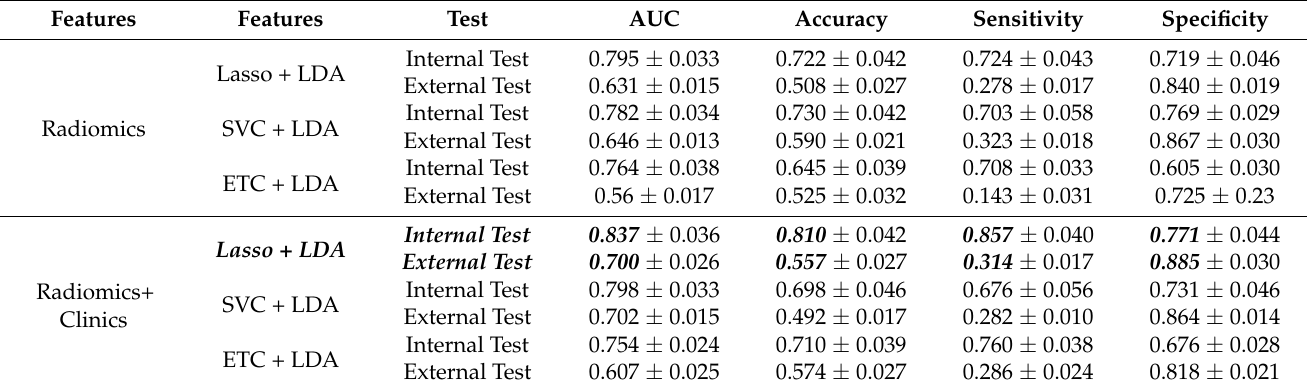
Table 4. Predictive model performance in the internal test and external